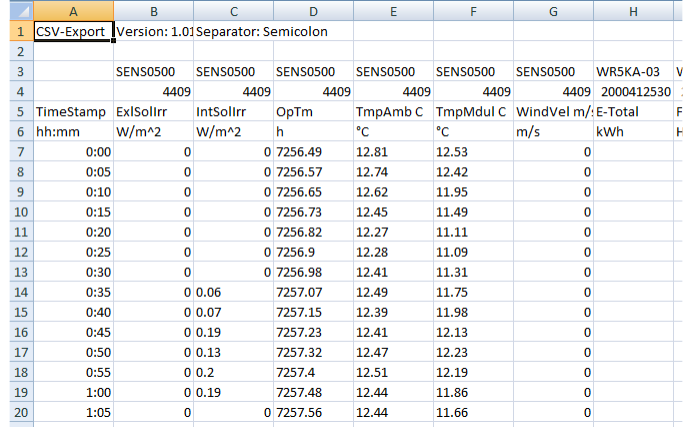
Figure 4. Part of the contents of a CSV file opened in Microsoft Excel from the monitoring of a PV plant.